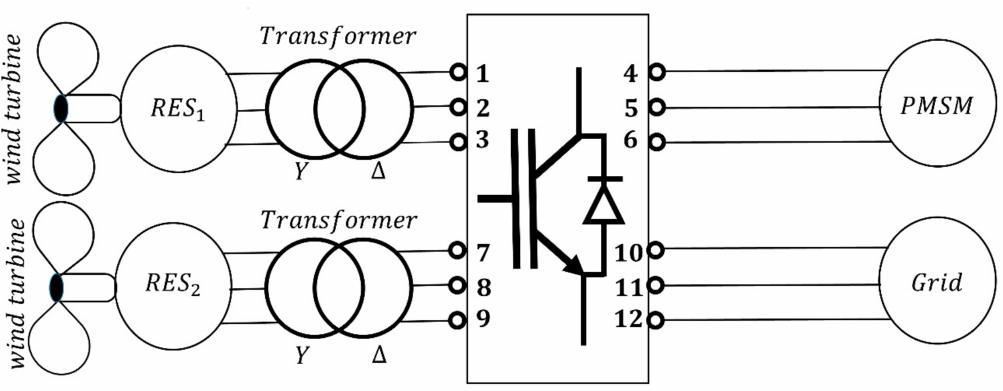
Figure 1. AC microgrid employing the compact converter.